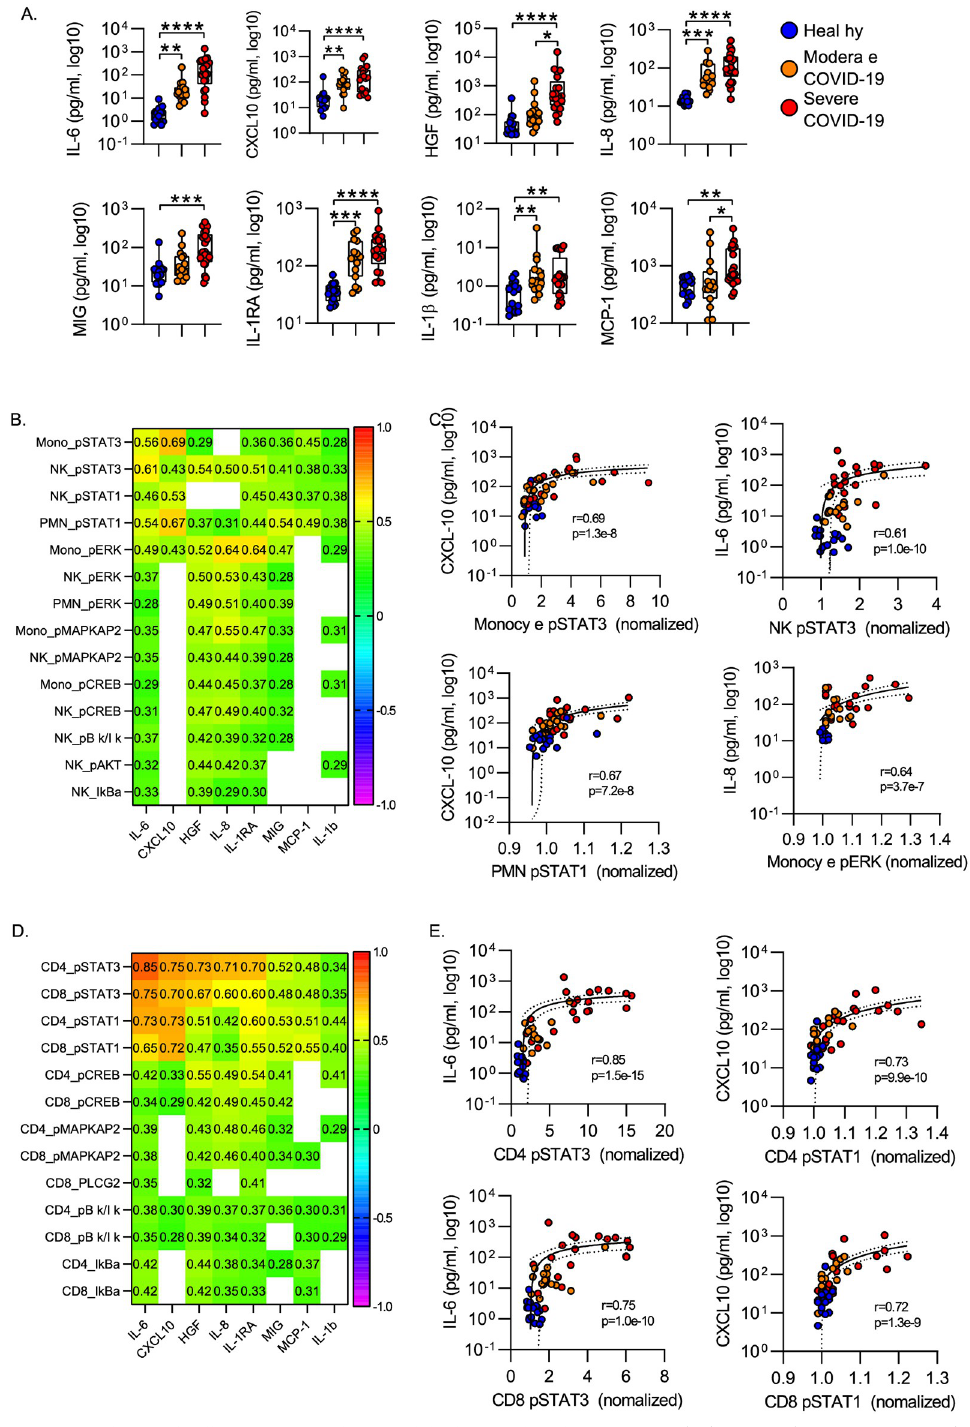
Fig 5. Correlation of Inflammatory cytokines with leukocyte phosphoproteome. A) Plasma cytokines were measured in a multiplex cytokine assay. � p < 0.05, �� p < 0.01, ��� p < 0.001, ���� p < 0.0001 by Dunn’s multiple comparisons test after nonparametric (Kruskal-Wallis) ANOVA with correction for FDR < 1% (Benjamini, Krieger and Yekutieli). Box plots represent 25-75 th percentile with line defining group median, with all data-points overlying. Error bars extend from minimum to maximum values. B) Heatmap of Spearman correlation between phosphoprotein signal intensity and plasma cytokine levels for innate immune cells. C) Correlation between cellular phosphoprotein levels and